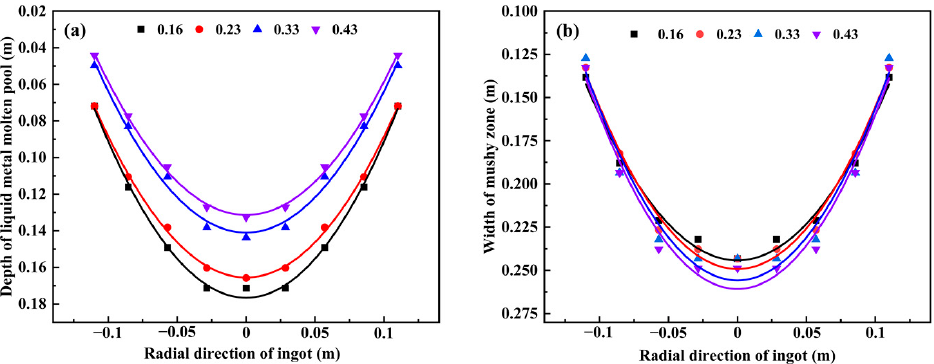
Figure 5. Change of metal pool depth ( a ) and mushy zone width ( b ) along radical direction with varying filling ratios.